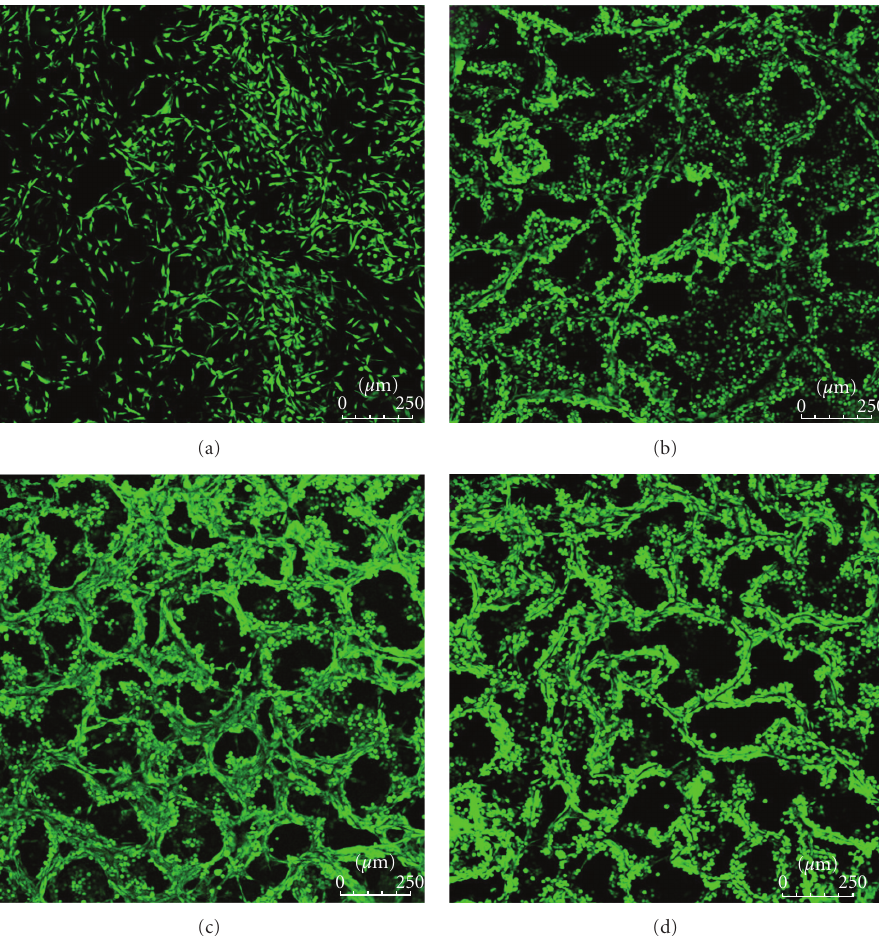
Figure 6: CLSM images of L929 fibroblast cells cultured in the hybrid sca ff olds. (a) Col:NP = 6:0; (b) Col:NP = 6:1; (c) Col:NP = 6:3; (d) Col:NP = 6:6 (w:w).